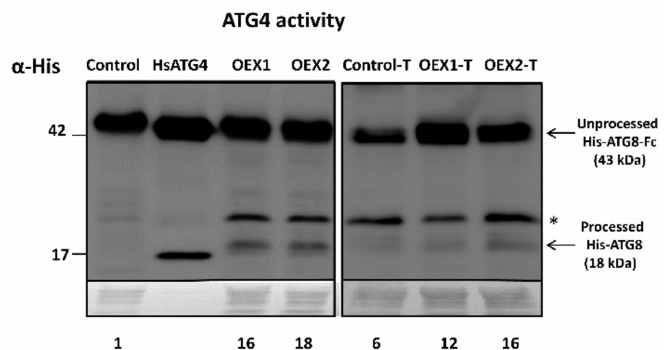
Figure 3. Endogenous ATG4 processing activity of control and two overexpressing Pstrxo1 (OEX) TBY-2 lines at day 6 of growth ( left panel ) and 24 h after 35 mM H 2 O 2 treatment (treated cells (-T), right panel ). ATG4 activity of cellular extracts in the presence of DTT, monitored by following the cleavage of recombinant quimeric His tag ATG8 substrate from the unprocessed (His.ATG8-Fc) to the processed His-ATG8) forms (indicated by arrowheads) by Western blot analysis using anti-His antibody. The activity of recombinant HsATG4 is shown as positive control. Asterisk indicates a non-specific band. Values are the mean of three experiments quantified after densitometry of the detected 18 kDa bands (see numbers below the membrane relatives to the signal in the control